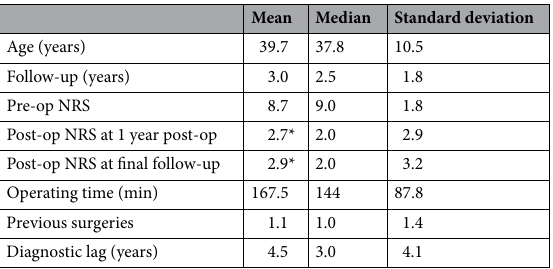
Table 1. Patient demographics and surgical outcomes. *Paired Wilcoxon’s test comparing pre-op NRS and post-op NRS at 1 year and final follow-up (p <